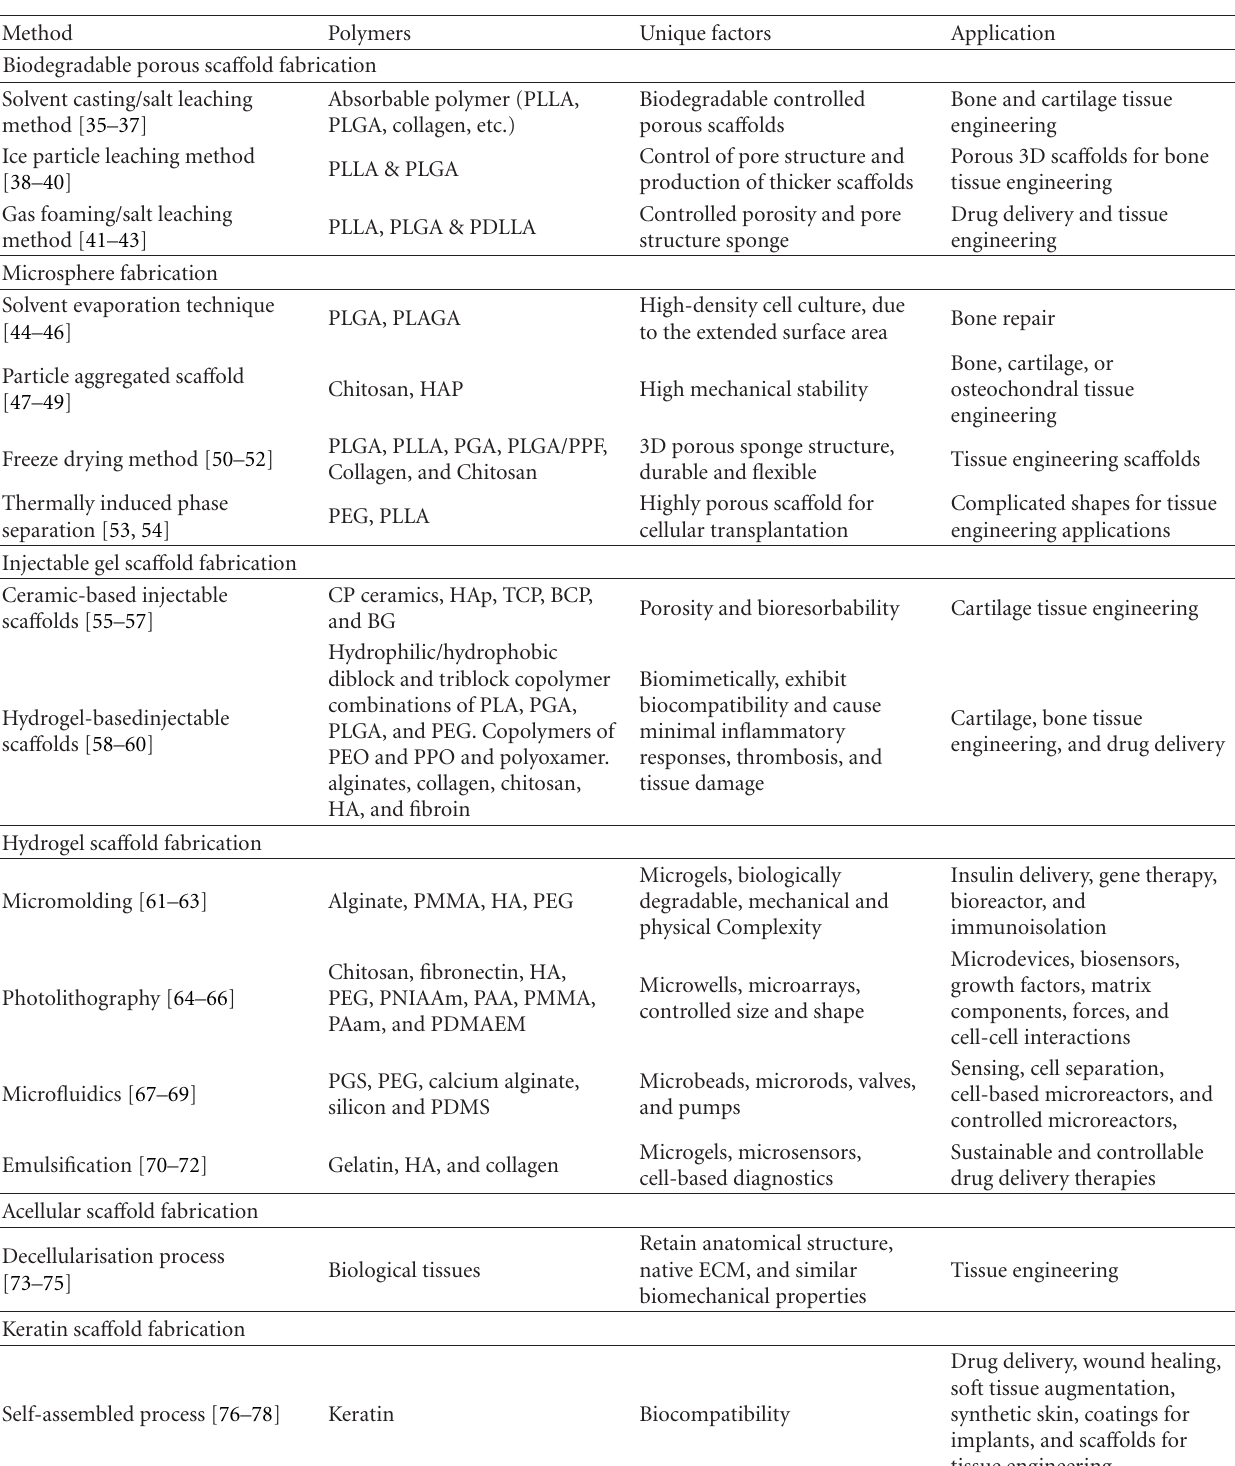
Table 1: Sca ff olds’ fabrication techniques in tissue engineering